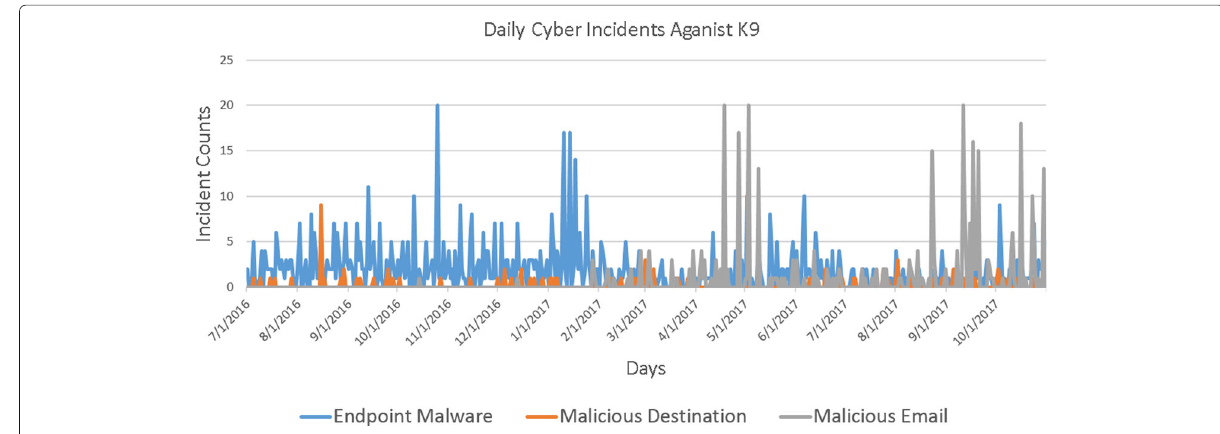
Fig. 2 An overview of the daily cyber events against